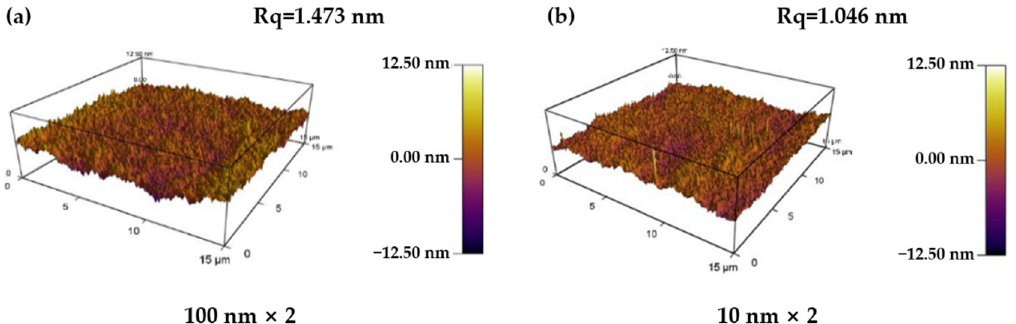
Figure 3. The surface morphology of pristine amorphous ZrC/nanocrystalline Ni multilayers: ( a ) 10 nm and ( b ) 100 nm.